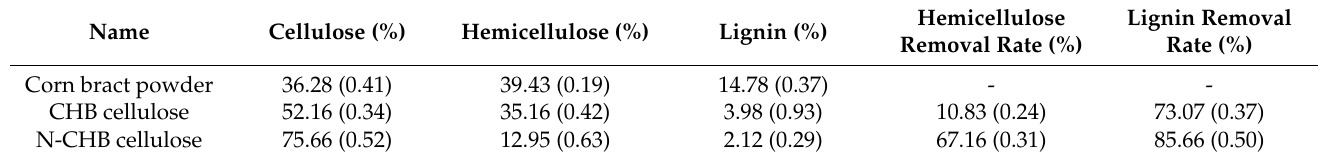
6 of 13 Figure 3. Appearance morphology of each step in the N-CHB cellulose extraction process: ( A ) Corn bract powder; ( B ) Sample treated with NH 3 ·H 2 O; ( C ) Sample further treated with CH 3 COOH/H 2 O 2 ; ( D ) N-CHB cellulose. 3.1.2. The Contents of the Three Major Elements The main components of corn bract include cellulose, hemicellulose and lignin [8]. After determination, the results are presented in Table 1, where the cellulose, hemicellu-